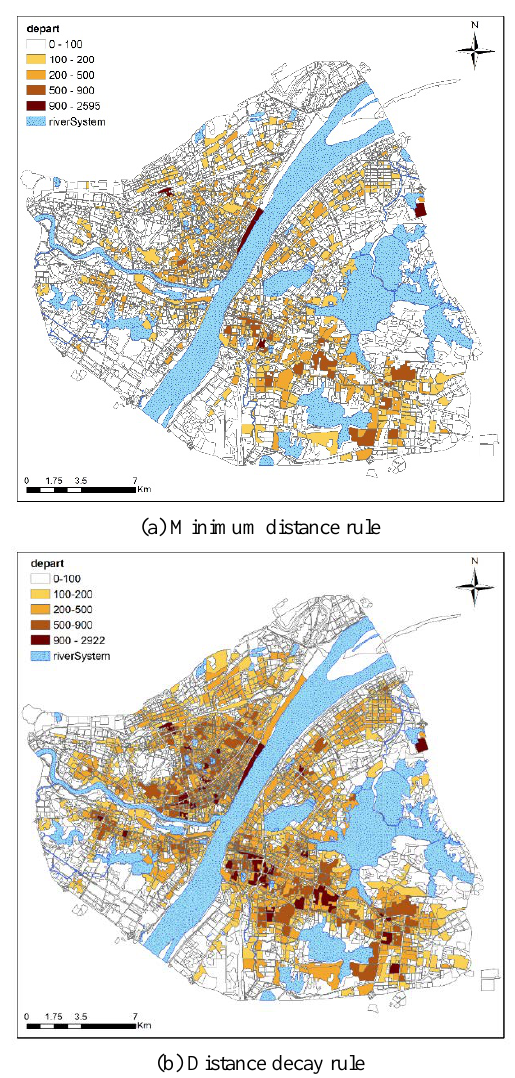
Figure 4. The depart activity intensity in all land use parcels in 9/7/2012 when adopting different allocation